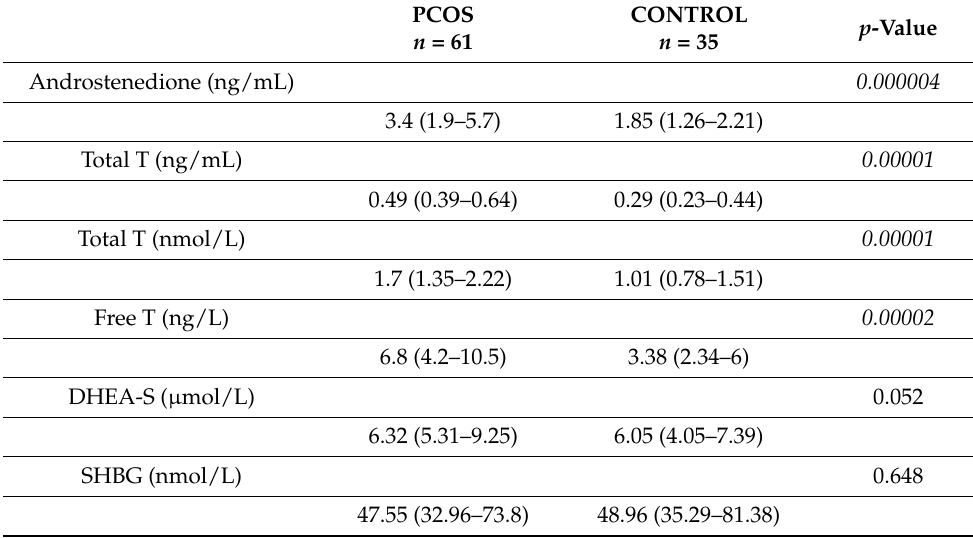
Table 1. Hormonal characteristics of the PCOS and CONTROL